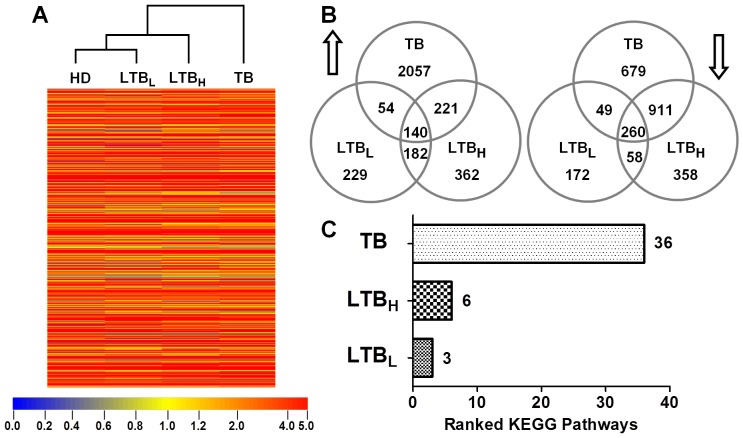
Bioinformatics analysis of gene expression in peripheral CD4+ T cells. A. Whole genome datasets of peripheral CD4+ T cells were analyzed by hierarchical clustering. The HD and LTBL groups clustered directly as a new category, which was subsequently clustered with the LTBH group. The TB group did not directly cluster with any group. B. In accordance with a 2-fold change between LTBL/LTBH/TB and HD, the number of significantly up-regulated (up arrow) and down-regulated (down arrow) genes were identified in the LTBL, LTBH and TB groups when they were compared to the HD group. Overlapping areas represent the common significant genes shared by two or three groups. C. The enrichment p value was used to rank the KEGG pathways (p value <0.05, included significant gene ≥10) in the LTBL, LTBH and TB groups. The p value of a KEGG pathway implies the significance of the KEGG pathway; the smaller the p value, the more significant the KEGG pathway. The TB group had the largest number of ranked KEGG pathways (36 pathways). The LTBL and LTBH groups had three and six ranked pathways, respectively.